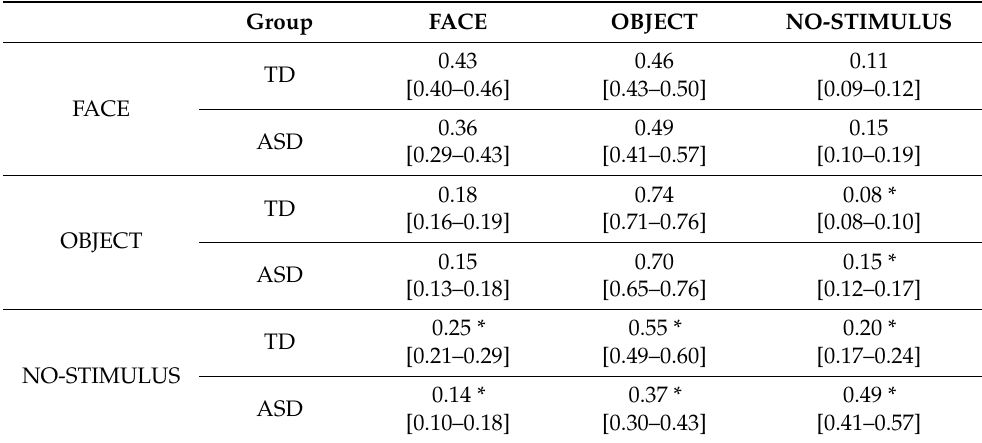
Table 2. Transition matrix of ASD and TD, lower and upper endpoints are reported between brackets (CI:95%).